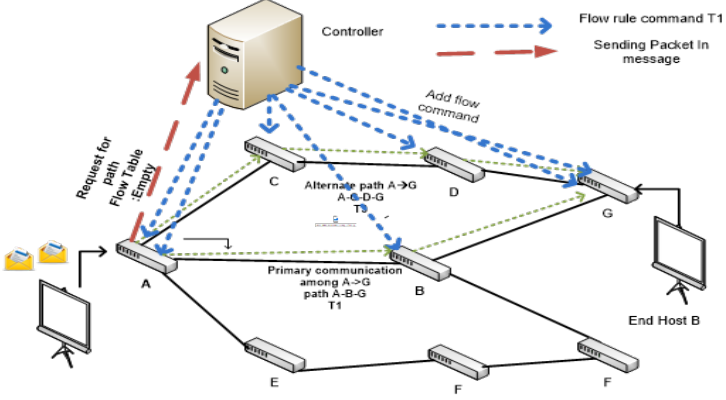
Figure 2. Proactive flow rule installation on two communication